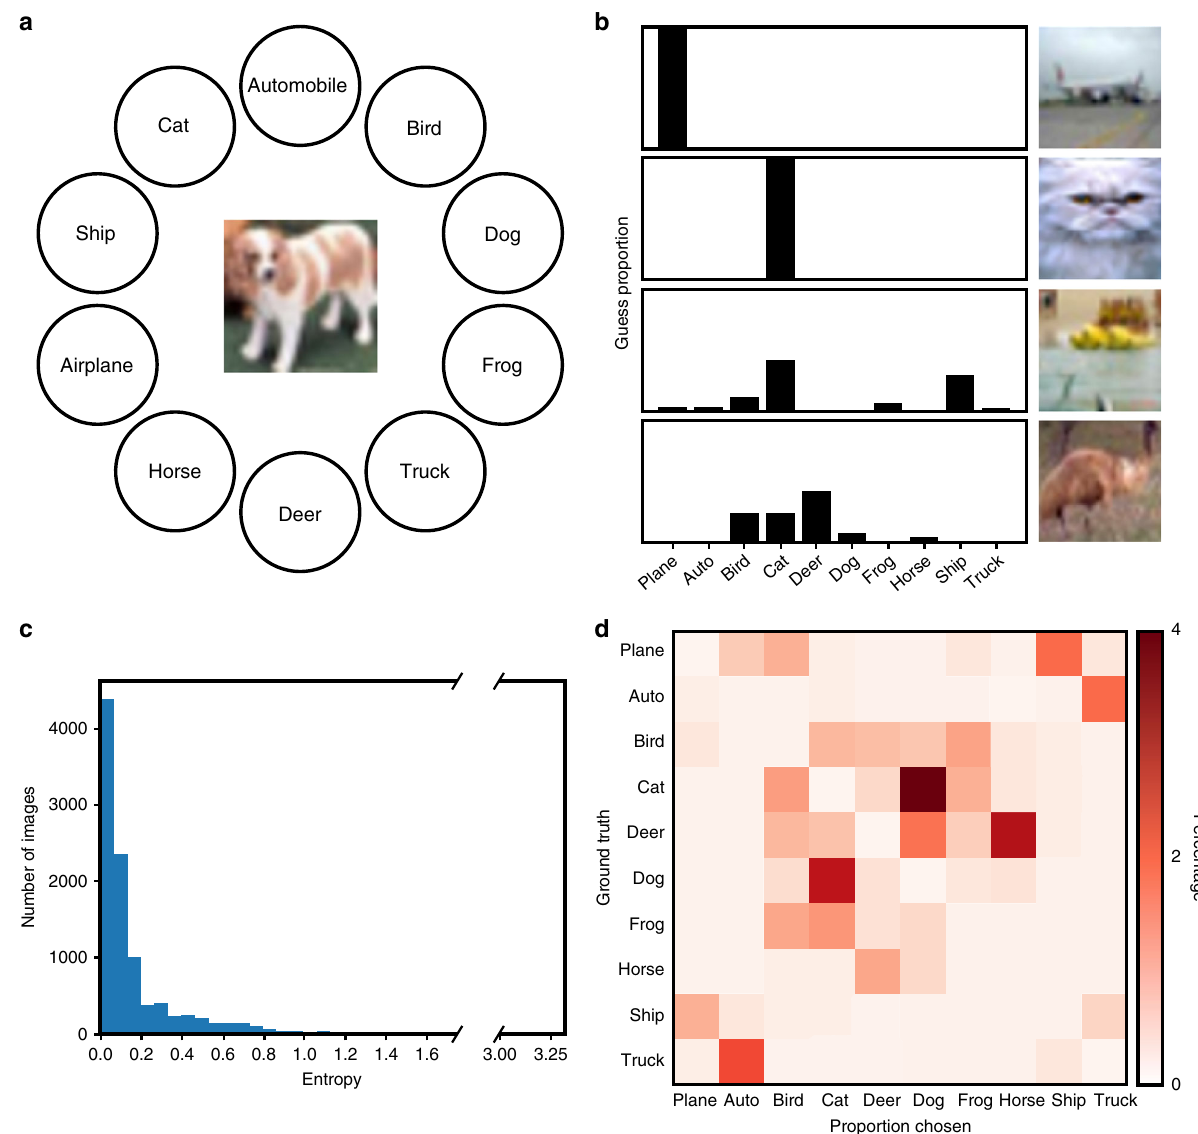
Fig. 3 Task paradigm and behavioral data. a Experiment web interface for our human categorization task. Participants categorized each image from an order-randomized circular array of the CIFAR-10 labels. b Examples of images and their human guess proportions. For many images (upper plane and cat), choices are unambiguous, matching the CIFAR-10 labels. For others (lower boat and bird), humans are far less certain. b The number of images by the entropy of their associated human guess distributions (less entropy means humans had greater consensus). d The confusion matrix for categories across all human judgments. Source data are provided as a Source Data fi